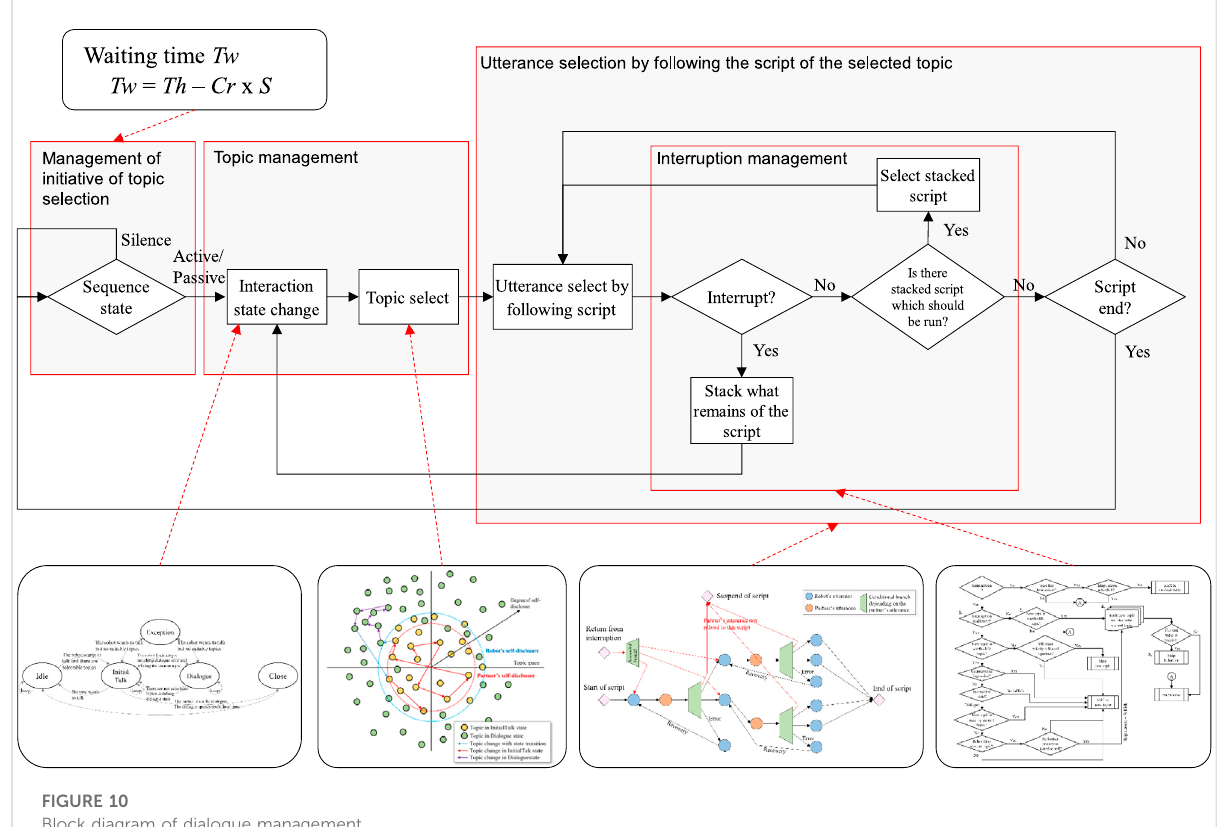
FIGURE 10 Block diagram of dialogue